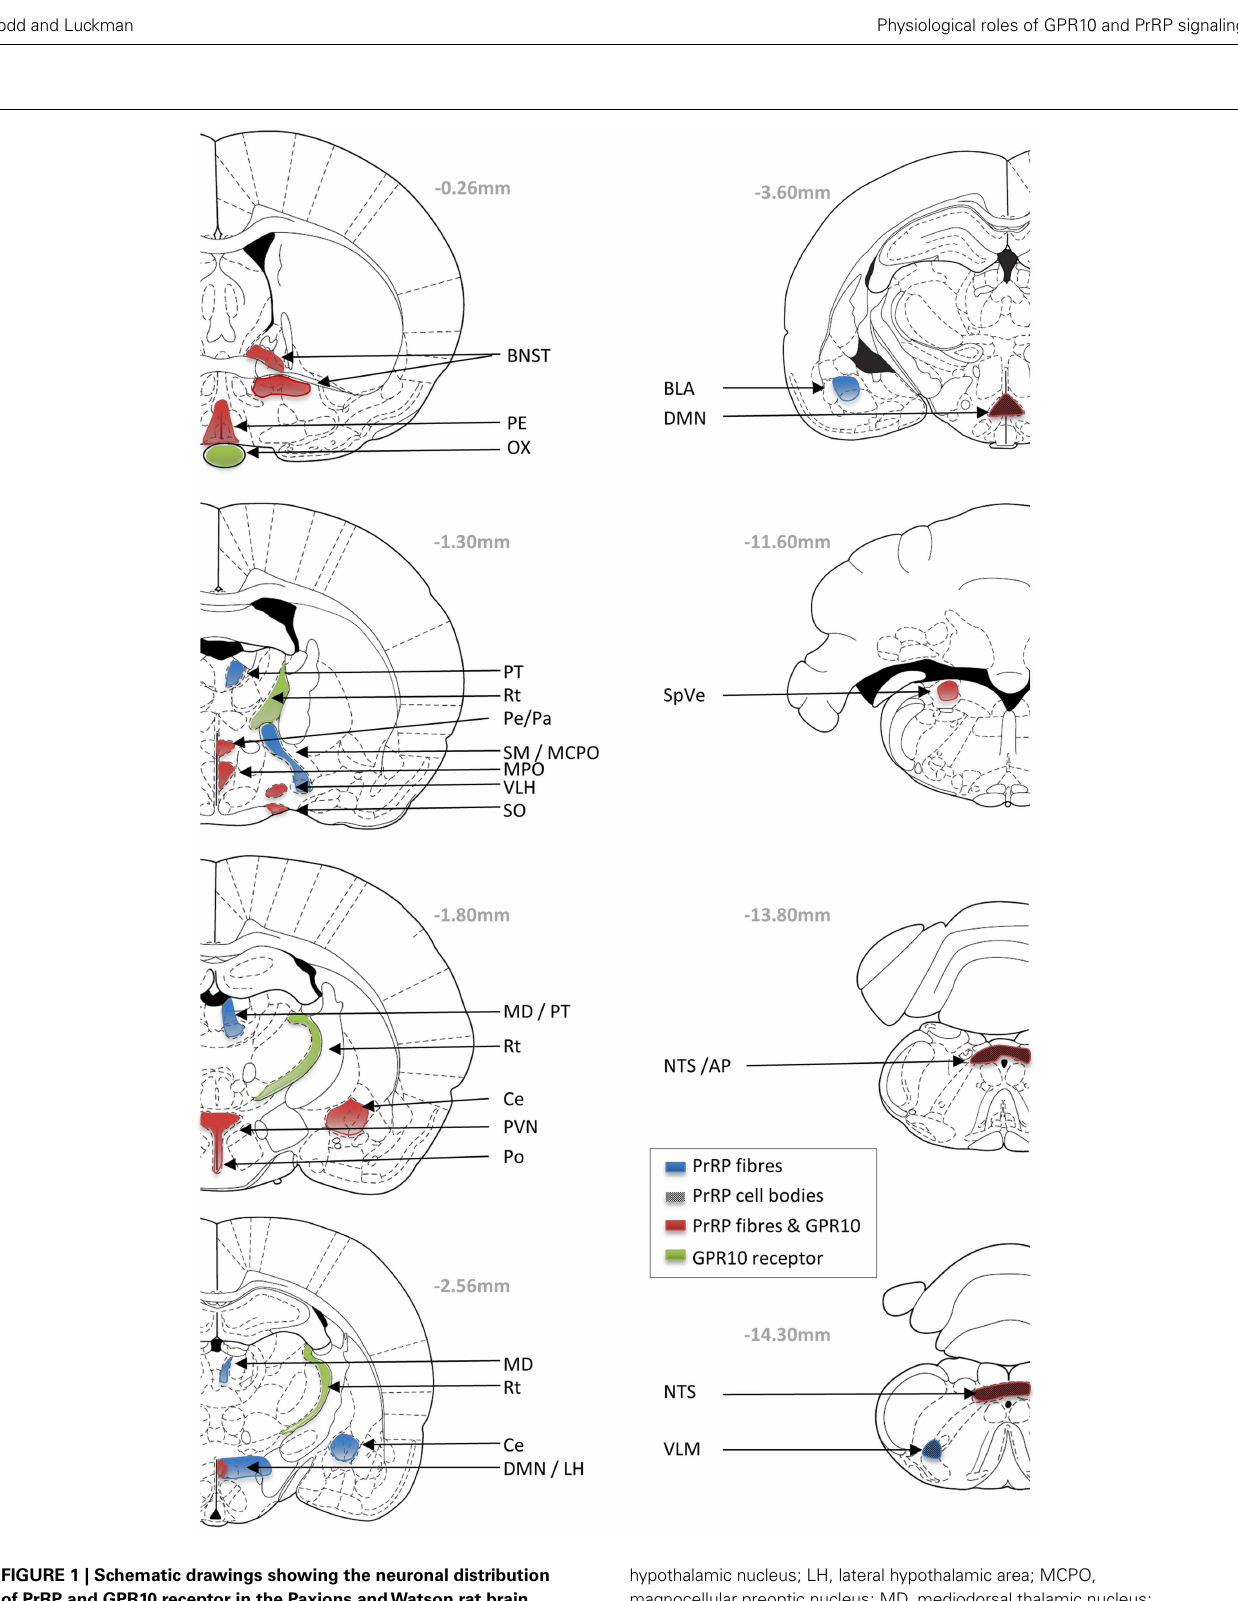
hypothalamic nucleus; LH, lateral hypothalamic area; MCPO, magnocellular preoptic nucleus; MD, mediodorsal thalamic nucleus; MPO, medial preoptic nucleus; ox, optic chiasm; PVN, paraventricular hypothalamic nucleus; Pe, periventricular hypothalamic nucleus; PT, paratenial thalamic nucleus; Rt, reticular thalamic nucleus; SM, nucleus of the stria medullaris; SO, supraoptic hypothalamic nucleus; NTS, nucleus of the tractus solitarius; SpVe, spinal vestibular nucleus;VLH, ventrolateral hypothalamic